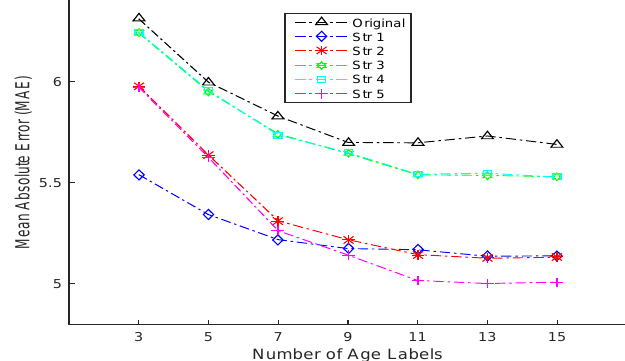
Figure 9. The line chart (variation tendency) of MAEs with respect to different number of age labels for the original LDL and the proposed SDM-LDL with different strategies when age label distribution is generated as multi-label with equal description degrees .